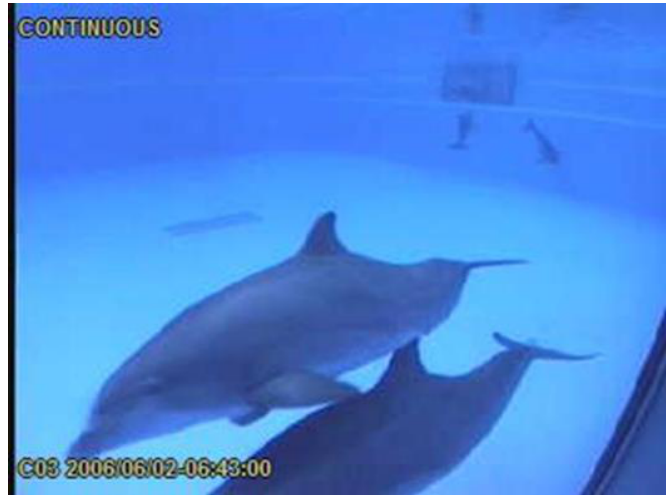
Figure 13 . Dorsal Mount (DM) of animal 1 by animal 2.